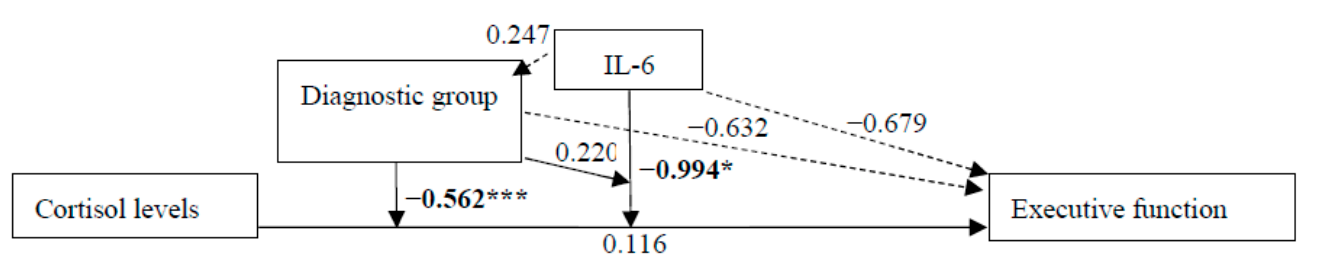
Figure 3. Unstandardized regression coefficients for the relationship between cortisol levels and executive function with moderators IL-6 and diagnostic group (CNI vs. MCI) in the total sample. Sex, waist circumference, depression diagnosis, and performance in a receptive vocabulary task, as a measure of educational level, were included as confounders in all models. * p ≤ 0.05; *** p ≤ 0.001 .